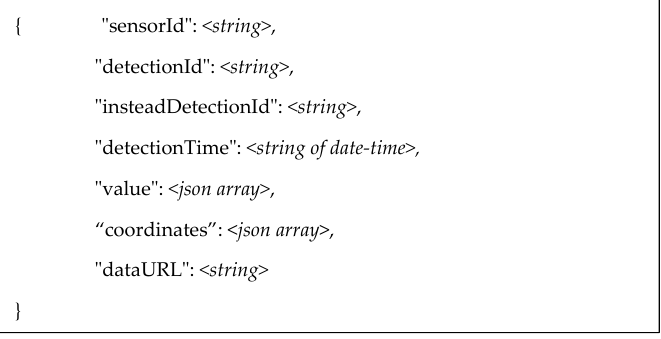
Figure 8. JSON message template for a generic sensor result. displayed in Figure 9. These messages, received by the C&C, lead to a data fusion